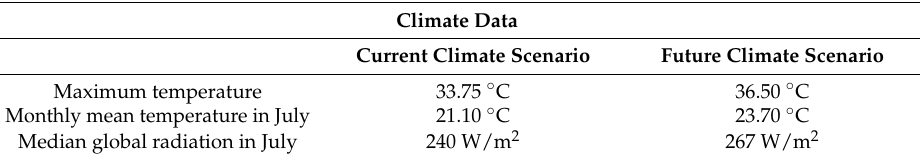
Table 2. Climatic data for the current and future climate scenario.